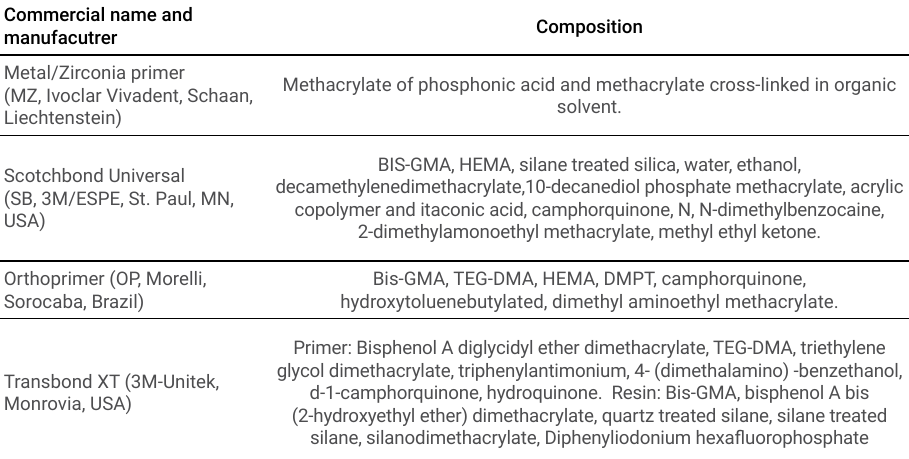
Table 1. Composition of the metal primers and orthodontic